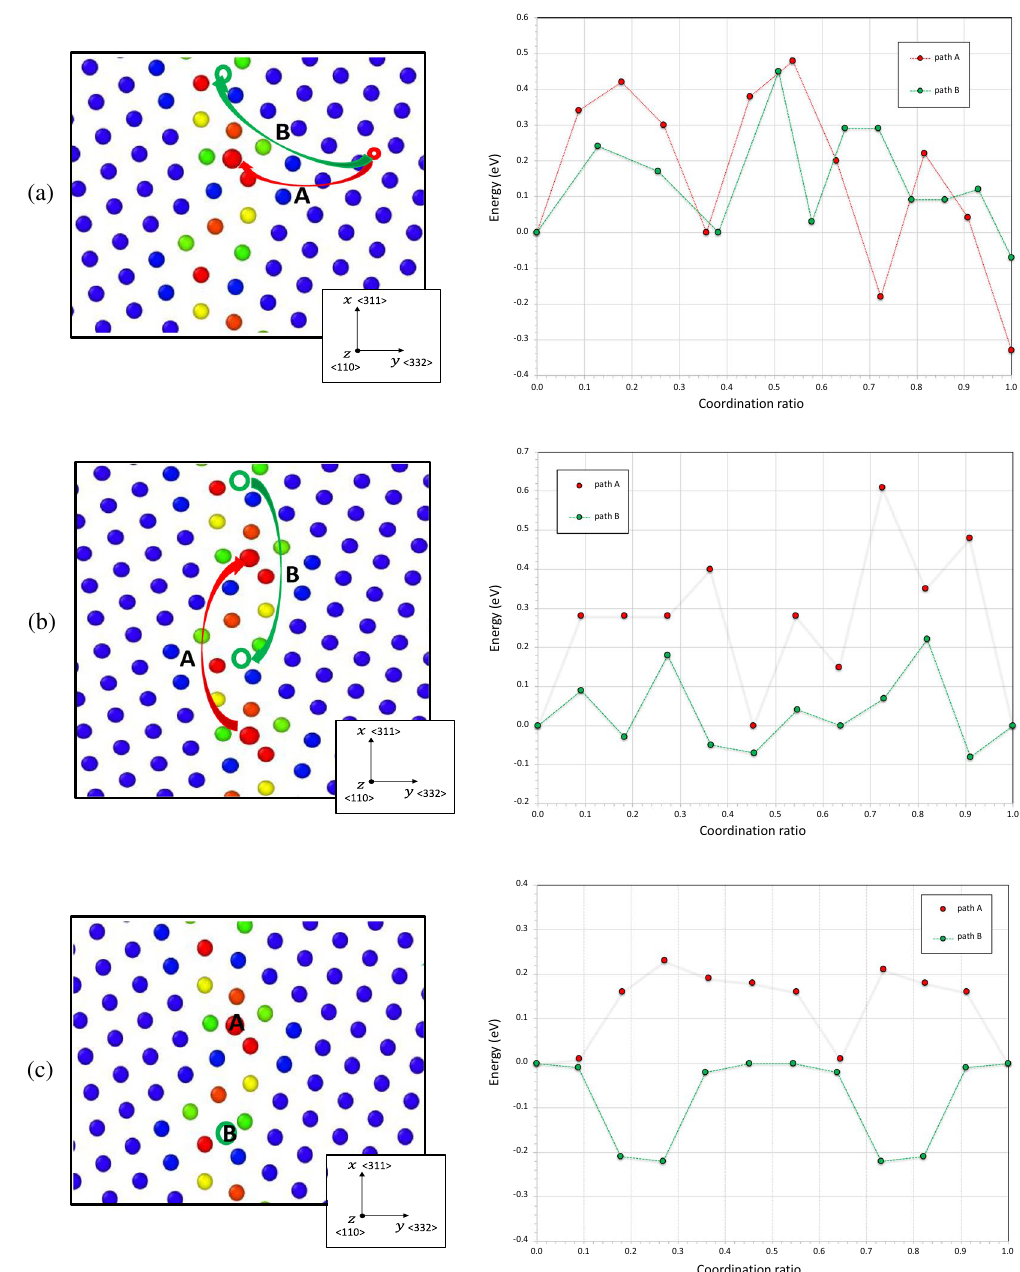
Figure 6. Energy barriers and minimum energy path between the known initial and final states for the GB Σ11–{332}. ( a ) Diffusion paths perpendicular to the grain boundary y = 〈 332 〉 . ( b , c ) diffusion paths along the grain boundary respectively for x = 〈 311 〉 and z = 〈 110 〉 . A is the path between the most stable segregation positions and the bulk. B is the path between the highest volume positions and the